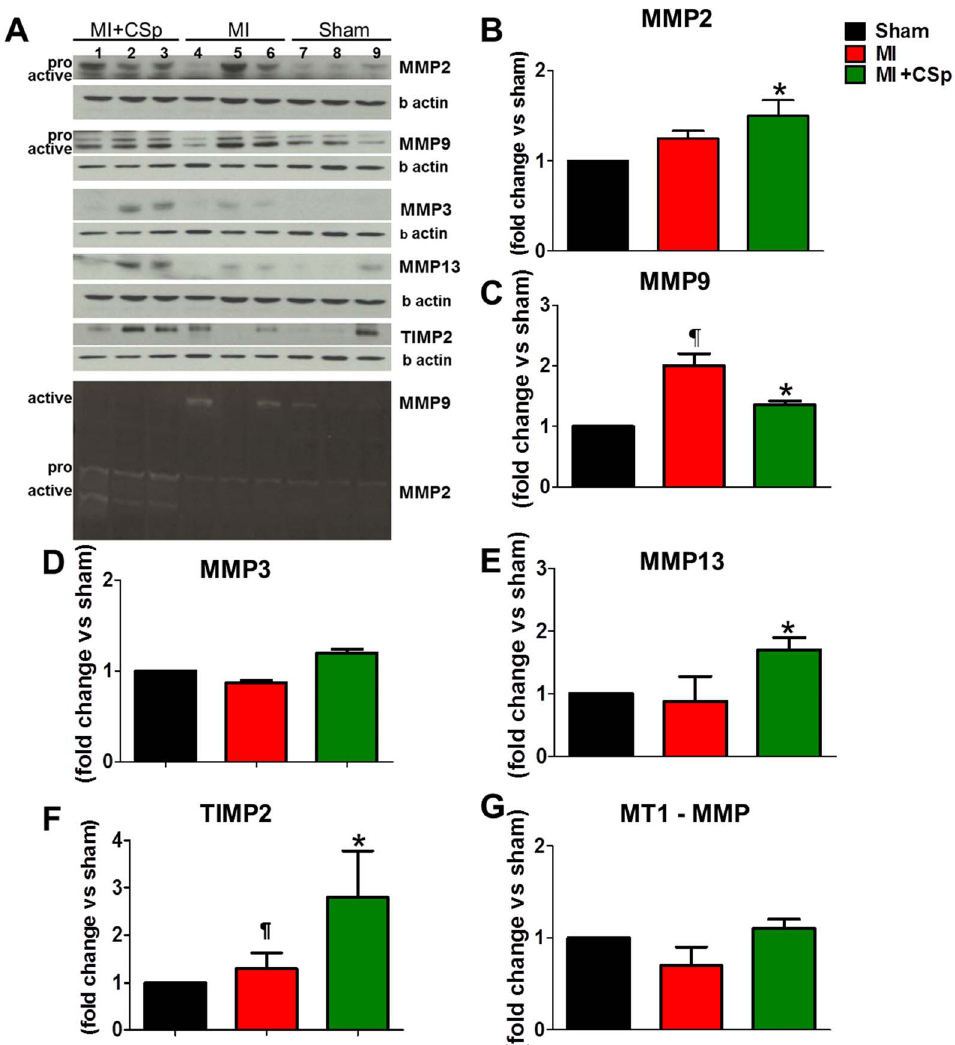
Figure 7. Metalloproteinase activity. (A) Immunoblotting (top 10) and zymograms (bottom membrane) were performed to examine the relative abundance of representative MMP types in myocardial tissue obtained from the peri-infarct zone 7 days post MI and CSp injection. For MMP2 and MMP13 the same membrane was used. For MMP9, MMP3 and TIMP2 the same membrane was used as well. The same samples were used in both membranes. All three samples in each group were evaluated. (B,E,F) Increases in MMP2, MMP13, and TIMP2 were observed in the peri-infarct zone of the post CSp transplanted myocardium. (C) In contrast, relative levels of MMP9 increased in the control compared to the treated group. (D,G) No differences were detected for MT1-MMP and MMP3. Data are mean 6 SD. " p , 0.05 control vs. MI + CSp, * p , 0.05 vs.